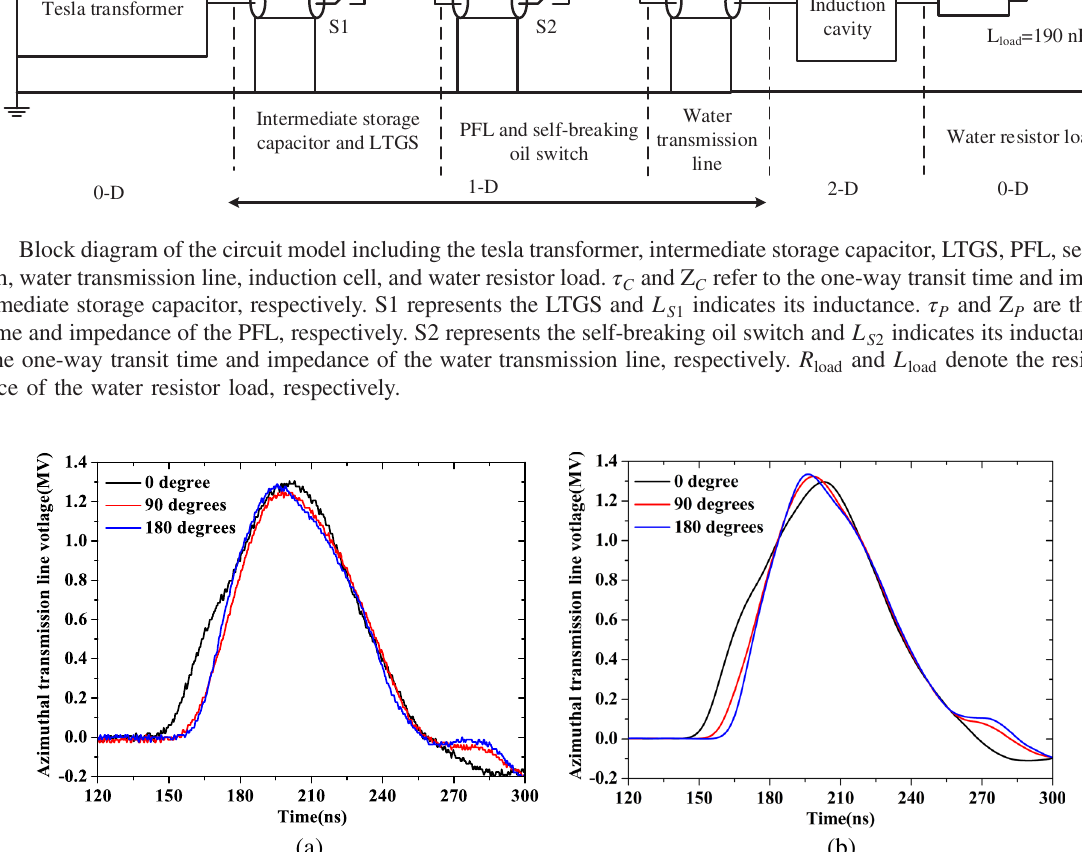
FIG. 11. The azimuthal transmission line voltage waveforms at 0 degree (black solid line), 90 degrees (red solid line), and 180 degrees (blue solid line) given by (a) experiment and (b) circuit simulation. As the length of feed port of our induction cell was only 257 mm and the D-dot sensor placed at the feed port was very close to the azimuthal transmission line, the voltage waveform given by this D-dot monitor was also able to be treated as azimuthal transmission line voltage at 0 degree. The maximum voltage at the azimuthal transmission line section is about 1.3 MV.